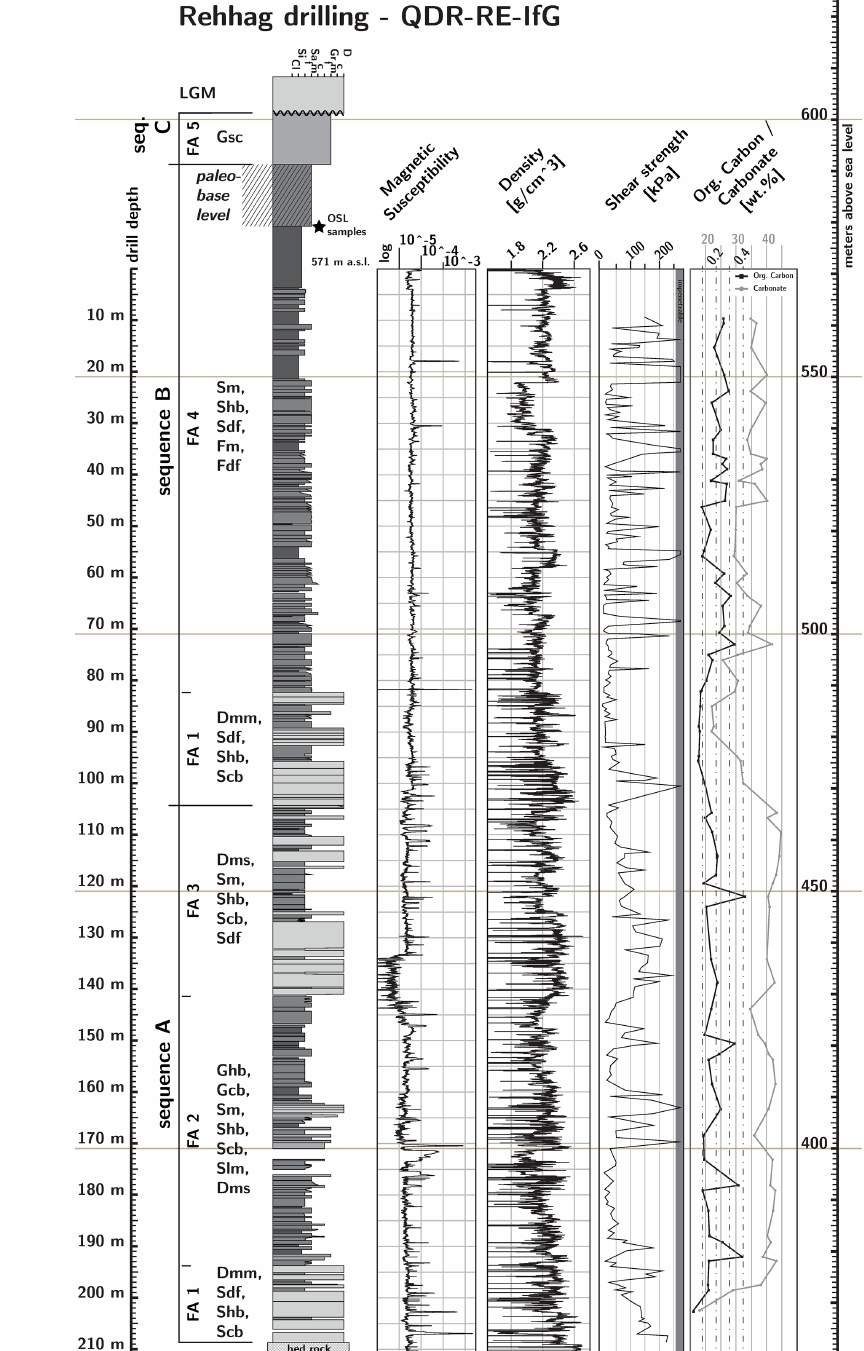
Figure 4. Drill log of the presented Rehhag drilling and the sequentially overlying outcrop in the Rehhag clay pit. Blank spaces in the log show considerable core loss. The depth from the top of the drilling is shown on the left-hand side and absolute elevation on the right-hand side of the figure. The figure also displays the logging results of the magnetic susceptibility, γ density, shear strength, TOC and CaCO 3 concentration measurements. The left-hand side of the log illustrates the distribution of lithofacies assemblage, and the respective lithofacies are noted. The sedimentary succession can be divided into two major sequences that were each initiated by a glacial advance. The basal till in each sequence is overlain by a thick assemblage of lacustrine deposits. The lower sequence A was formed in an ice-contact fan environment of a proglacial lake. The upper sequence B was formed from turbid underflows in a proglacial lake or deposited by turbid underflows in a lacustrine prodelta environment. The entire sequence is overlain by fluvial braidplain deposits, which can be considered a third sequence C, as this unit potentially transitions to another glacial period. An LGM till (Holocene) unconformably overlies the considerably older, Pleistocene